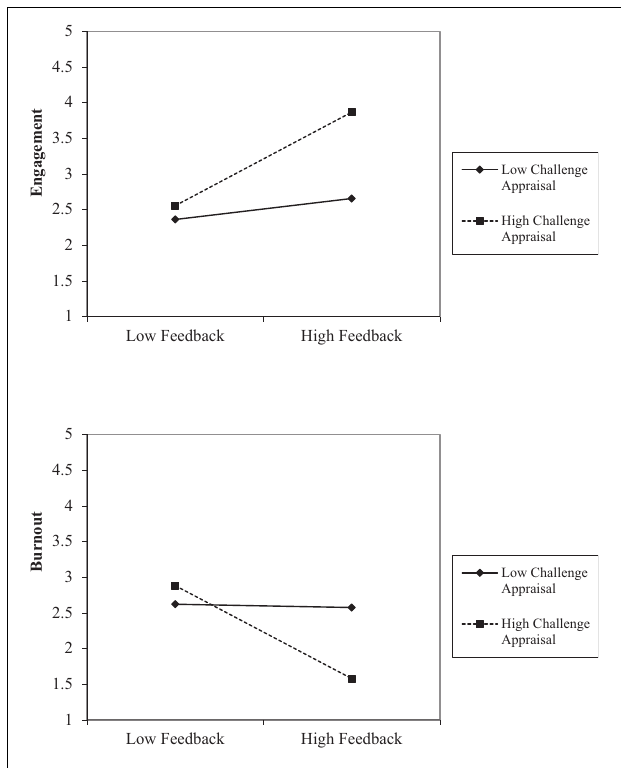
FIGURE 5 | The interactions between feedback and challenge appraisal on engagement (top) and burnout (bottom) in Study